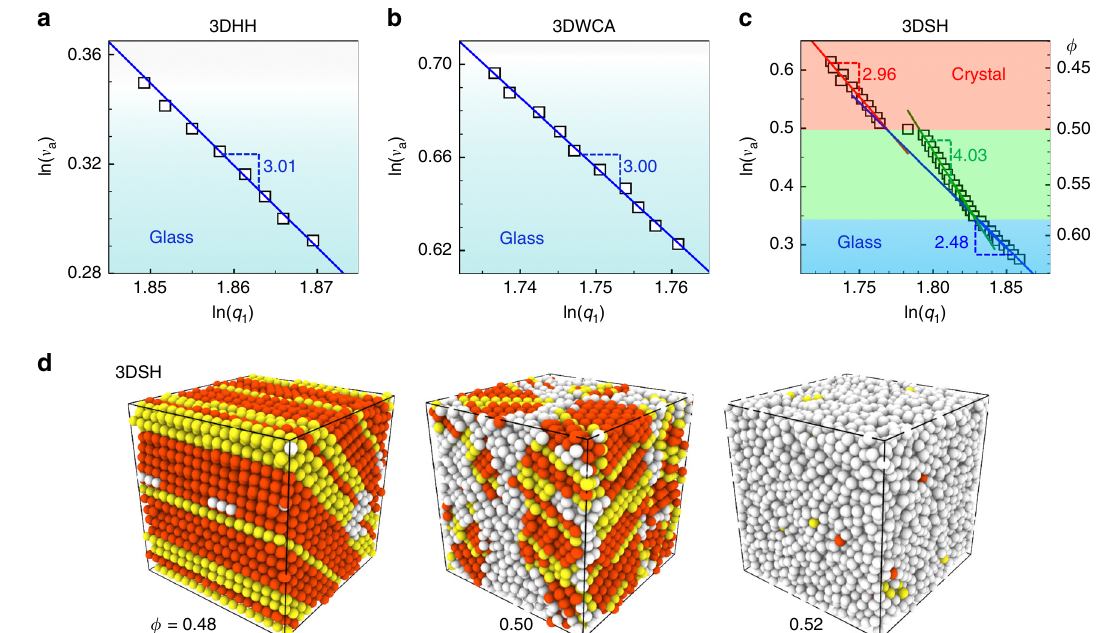
/ q (cid:2) d (cid:4) q (cid:2) d ( a , b ) v with d ≃ 3.0 in 3DHH and 3DWCA glasses with ( η , λ ) = (0.5, 1.3). c v Fig. 4 v a / q (cid:2) d in the 3D systems. v 1 1 1 a a crystal regime with d = 2.95 ≃ D (red line) and in the glass regime with d = 2.48 (blue line). Most of the crossover regime can be fi tted by v (green line). The abrupt jump of q 1 at ϕ = 0.5 re fl ects a fi rst-order-like transition in 3D. d Compression-induced crystal-glass transition in the 3DSH system with ( η , λ ) = (0.4,1.25). Orange, yellow and white spheres denote face-centered cubic, hexagonal close-packed and disordered particles, respectively. They are identi fi ed from the weighted bond-orientational order parameters (see Methods) 42,44 . The ordered structure becomes completely disordered in a small density range, 0.48 < ϕ < 0.52, re fl ecting a sharp transition at ϕ = 0.5.